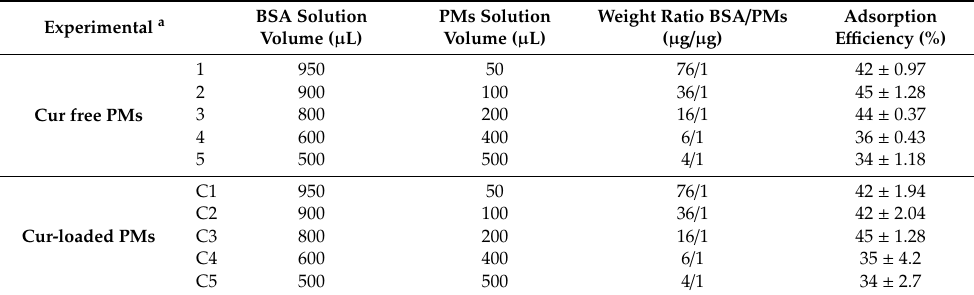
Table 4. Experimental data and adsorption e ffi ciency values of the BSA on the